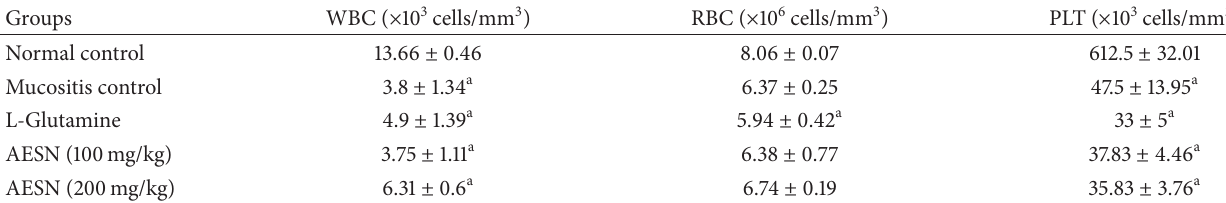
Table 3: Change in hematological parameters in busulfan and radiation induced oral mucositis.